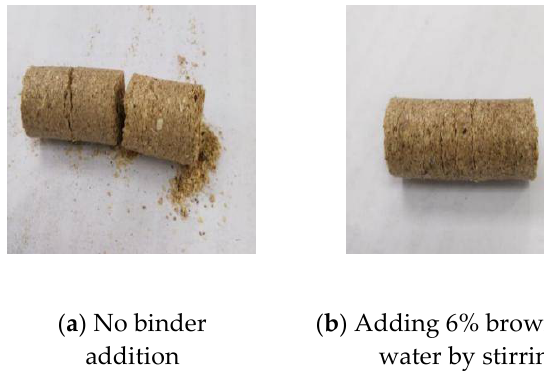
Figure 4. Densification effect. Table 2. Test results of relaxation density and surface quality of